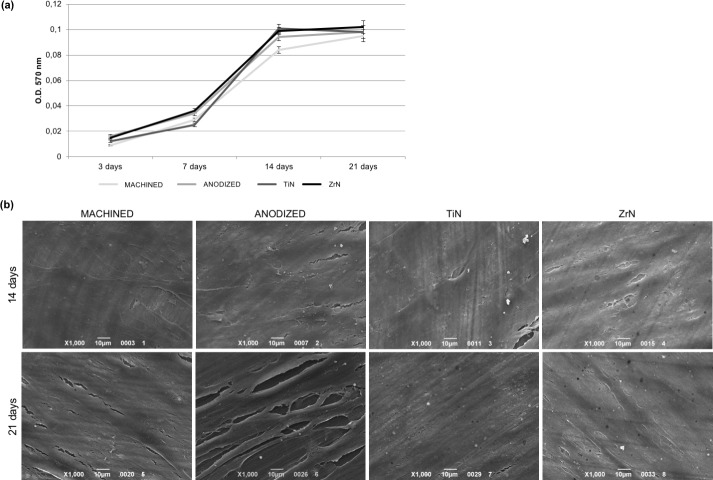
Proliferation of fibroblasts seeded on Ti disks.(a) MTT assay of HGFs cultured on the different Ti disks for 3, 7, 14 and 21 days shows that cells are vital and able to proliferate on all the surfaces examined. (b) SEM images (1000x magnification) of HGFs grown onto the four Ti disks reveal that cells reached confluence after 14 days from seeding, forming a continuous monolayer, which persisted up to 21 days.